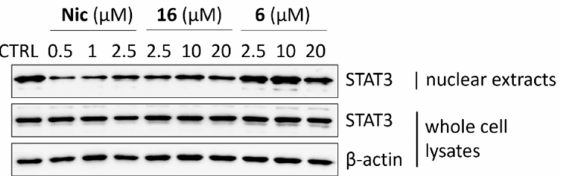
Figure 6. Compound 16 suppresses the EGF-induced nuclear translocation of STAT3 in human prostate cancer cells. Serum-starved DU145 cells were treated with compounds 6 and 16 at indicated concentrations for 2 h. Then the cells were stimulated with EGF (100 ng/mL) for 15 min, and the levels of STAT3 were detected by immunoblot analysis in nuclear extracts and whole cell lysates using an appropriate antibody. Samples treated by indicated concentrations of niclosamide (Nic) for 2 h were used as positive controls. Representative immunoblots of one out of at least three experiments are shown. CTRL, drug-free control.